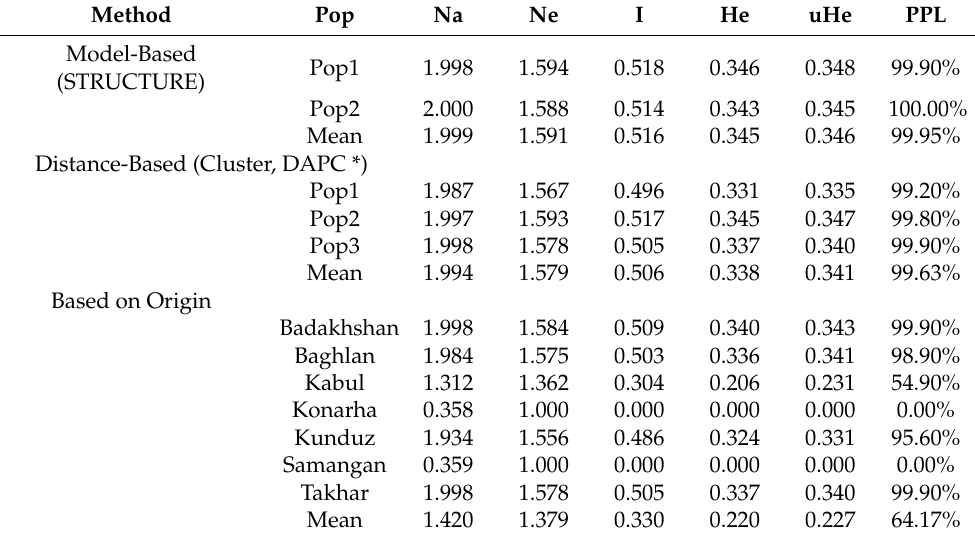
Table 5. Mean of different genetic parameters, including the number of different alleles (Na), the number of effective alleles (Ne), Shannon’s index (I), the diversity index (He), the unbiased diversity index (uHe), and the percentage of polymorphic loci (PPL) in each of the two subpopulations. Method Pop Na